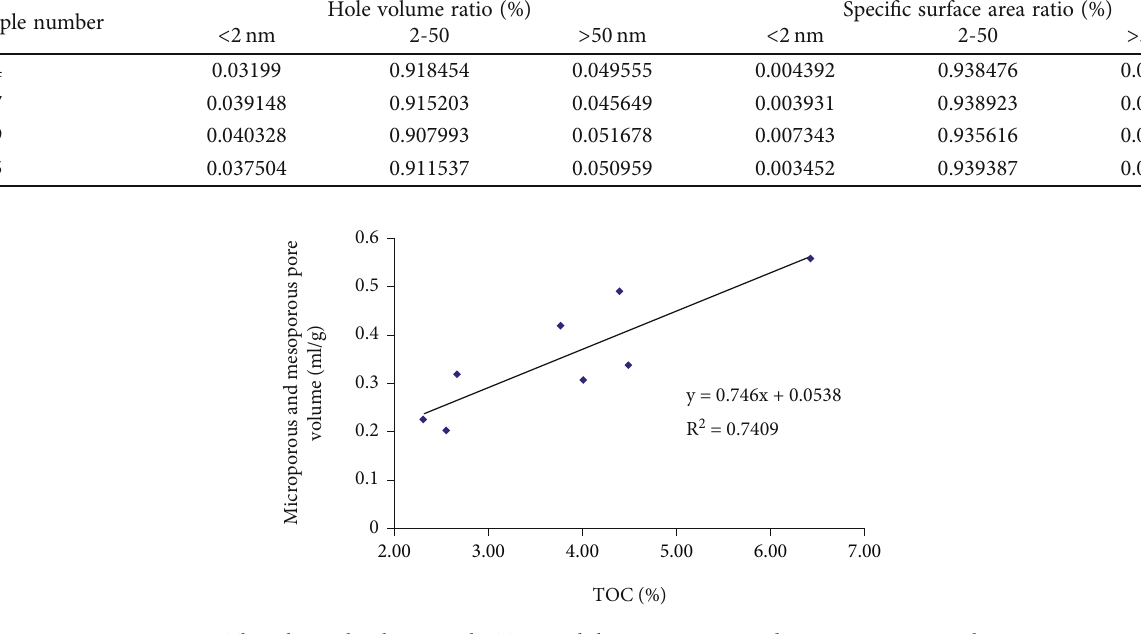
Figure 7: The relationship between the TOC and the microporous and mesoporous pore volumes.